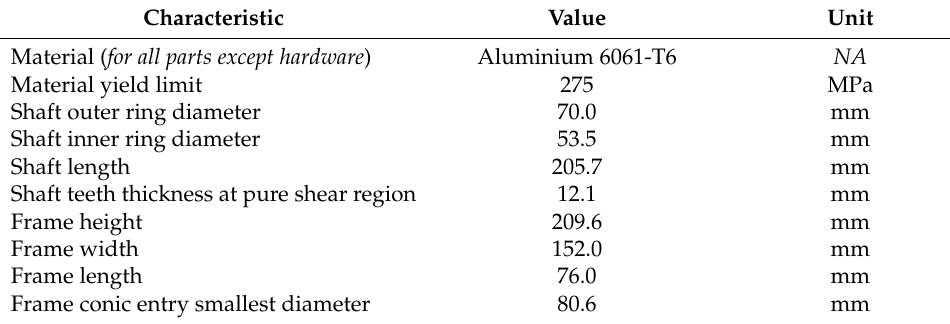
Table 2. Connector critical values,